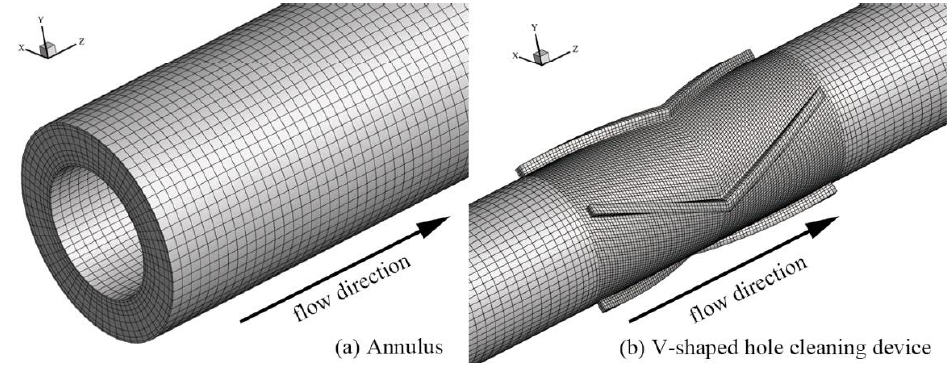
Figure 2. Grid representation of calculation region.